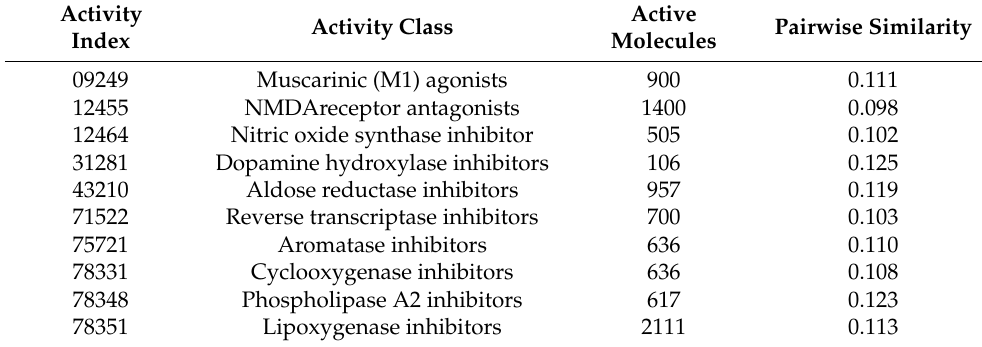
Table 6. MDDR activity classes for DS2 dataset.